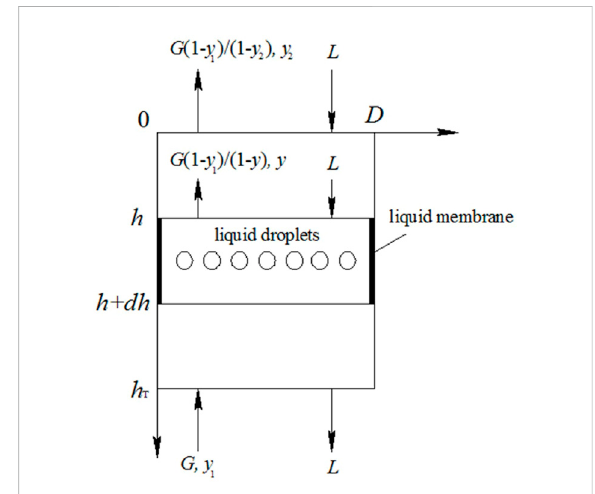
FIGURE 2 Schematic diagram of material balance for SO 2